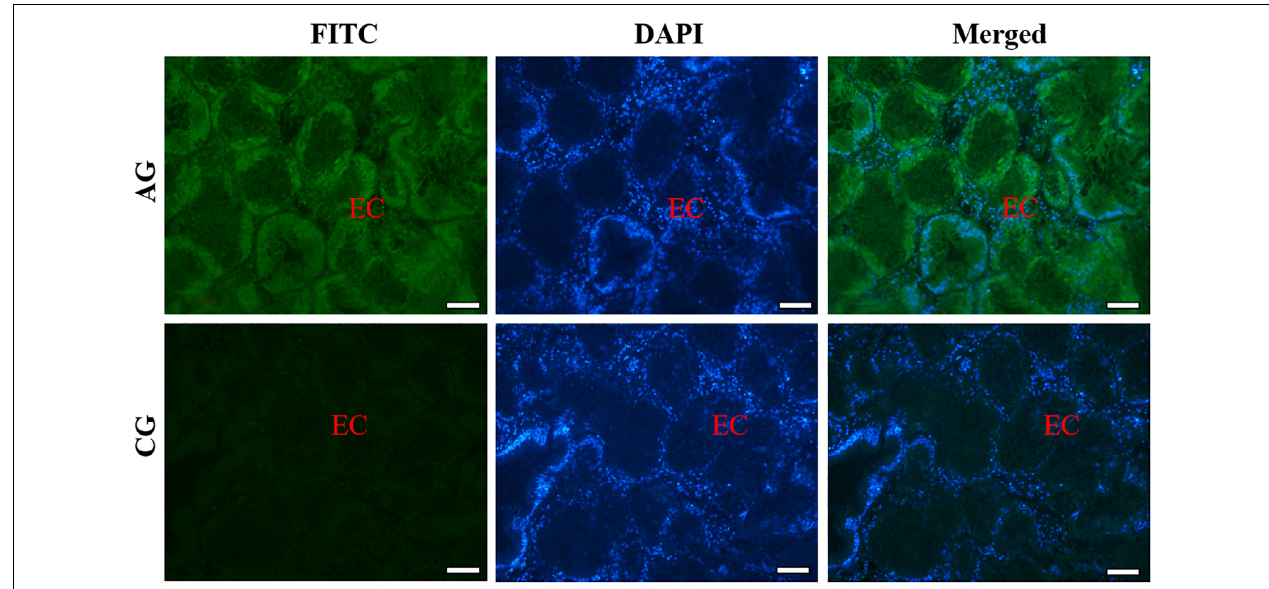
FIGURE 4 | Immunofluorescence of Sc-GDH in the hepatopancreas of S. constricta . Sc-GDH protein was stained with the anti-GDH antibody in green, and nuclei were stained with DAPI in blue. The merged images were co-localized with Sc-GDH protein (green) and DAPI (blue) in the endothelial cells of hepatic sinusoid. EC, endothelial cells. Scale bars were 50 µ m.